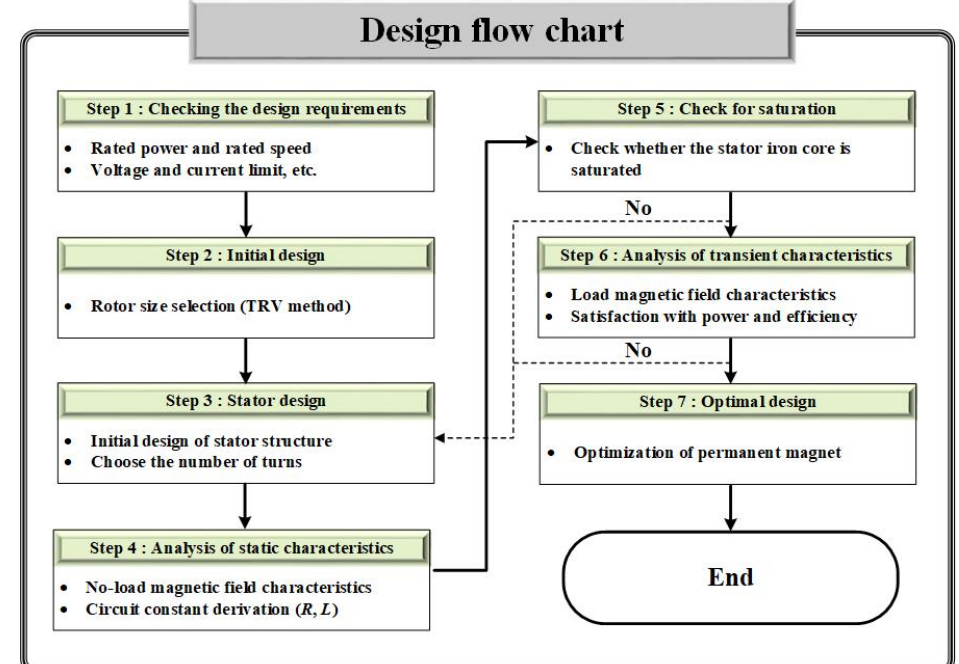
Figure 1. PMSG design flow chart.